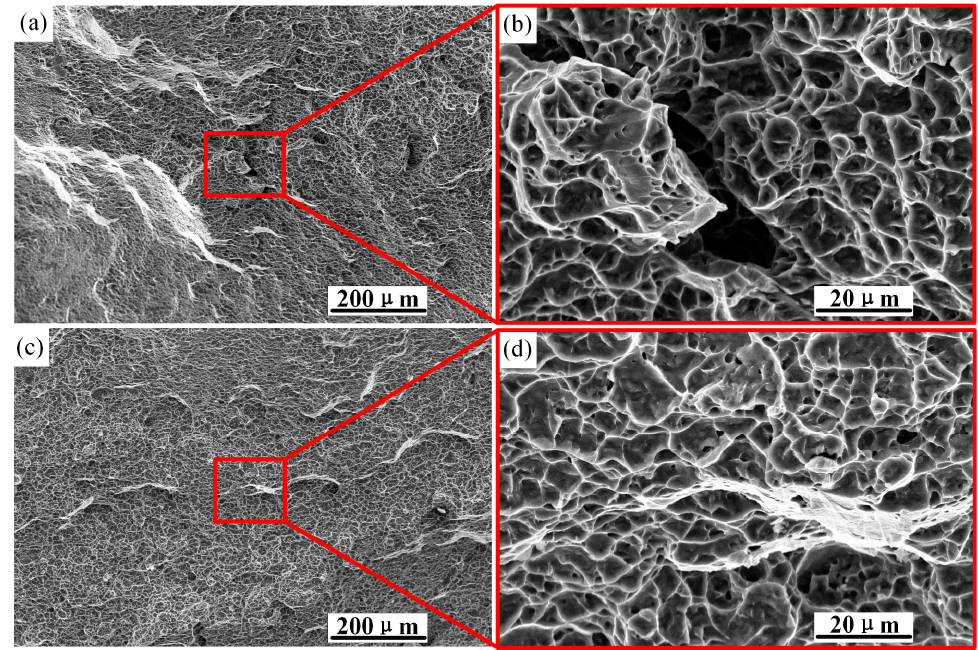
Figure 19. Fracture morphology of smooth specimens at 1000 and 4000 magnification: ( a ) strain rate 0.001 s − 1 ; ( b ) local magnification; ( c ) strain rate 0.01 s − 1 ; ( d ) local magnification.